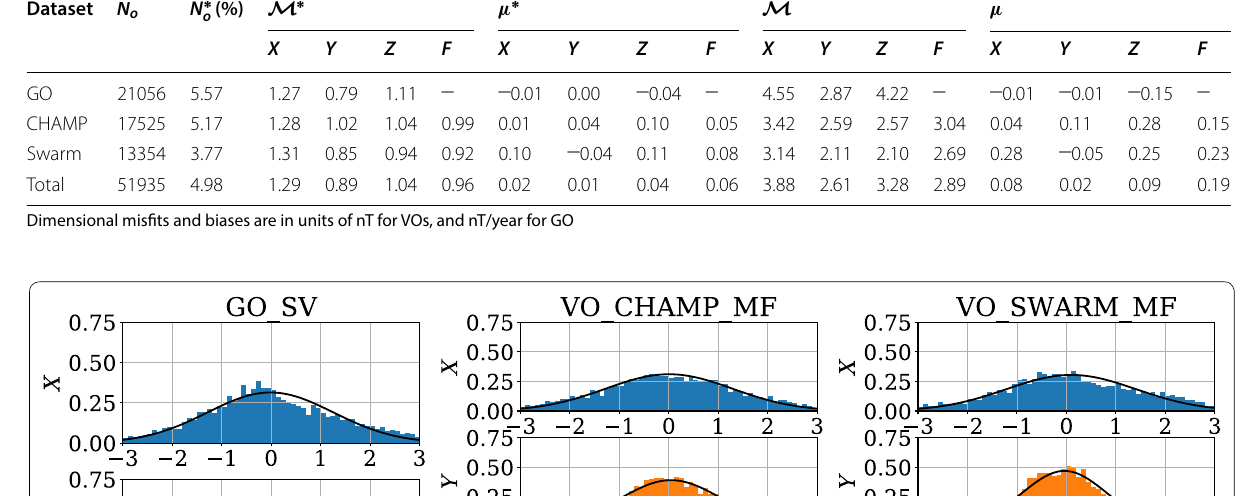
Table 2 Errors statistics for the GO and VO (CHAMP and Swarm) datasets integrated in COV-OBS.x2: accepted number of data N o , fraction of rejected data ( N ∗ o , in %), dimensionless L2 data misfit M ∗ and bias µ ∗ , and dimensional L2 data misfit M and bias µ Dataset N o